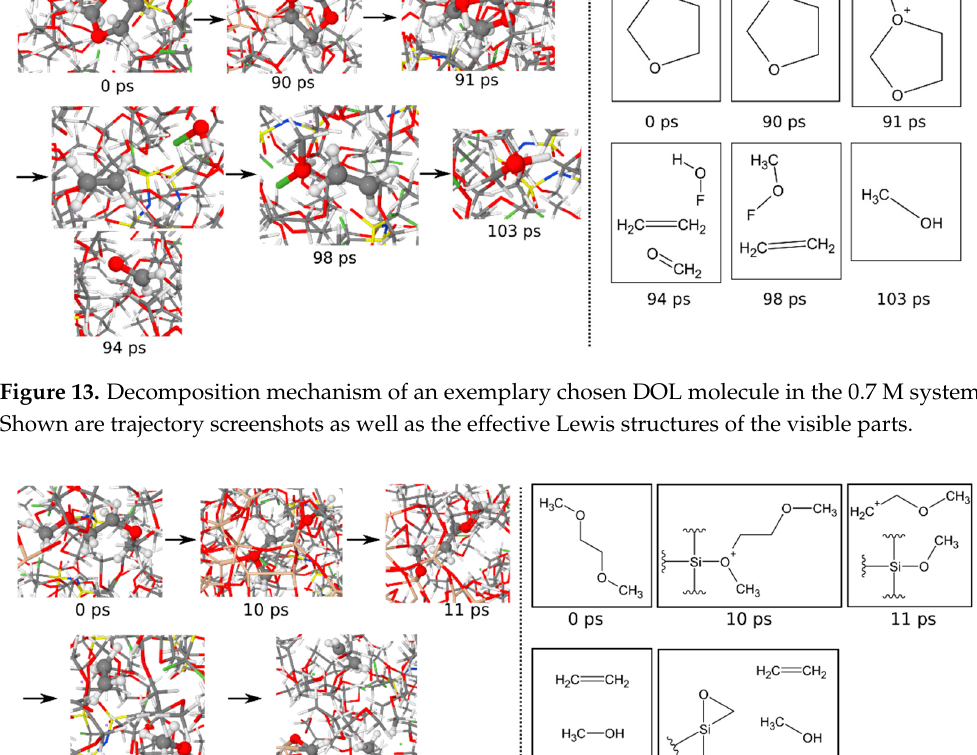
Figure 12. Space-resolved concentrations of the most abundant eight molecule species averaged over the first and last fifth of the overall dynamics. Shown are the results for 0.7 M LiTFSI for 0–280 ps ( a ) and 1120–1400 ps ( b ) as well as for 4 M LiTFSI for 0–280 ps ( c ) and 1120–1400 ps ( d ).